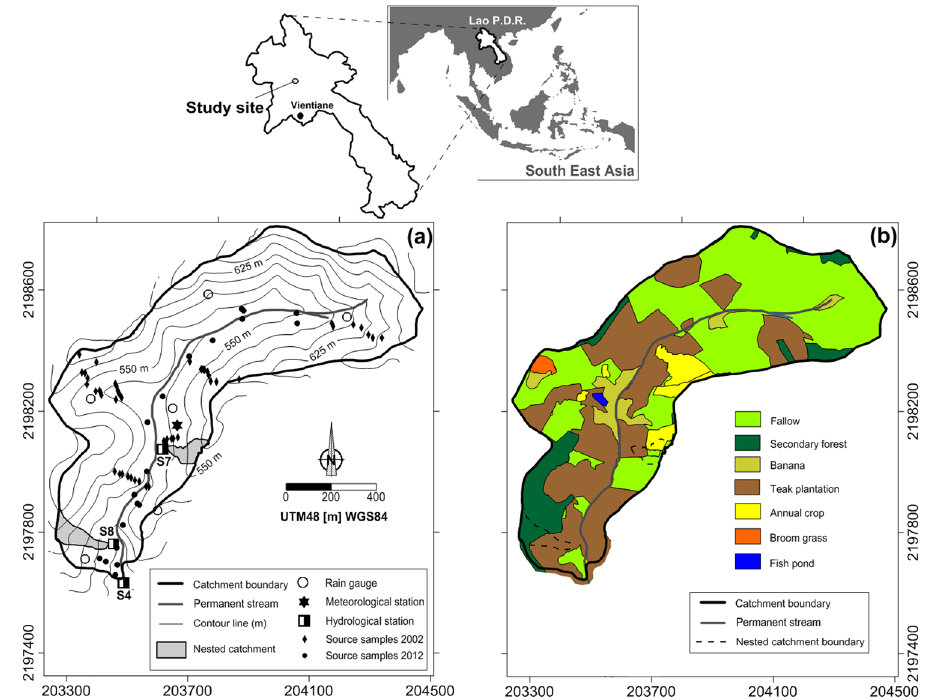
Figure 1. Monitoring devices and sampling sites in the Houay Pano catchment. This original map was created using Surfer 13.2.438 from Golden Software,